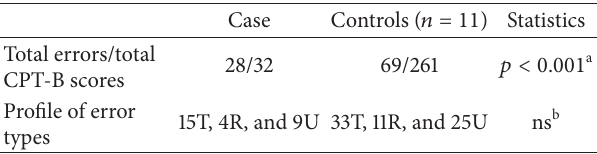
Table 3: Comparison of CPT-B performance between the case and normal